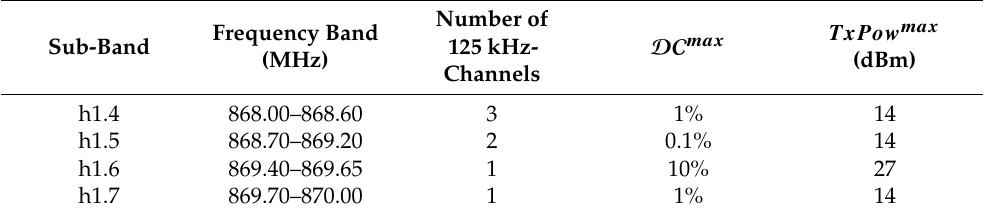
Table 1. Duty-cycle limitations of the sub-bands of the EU863-870MHz ISM band that match the ERC Recommendation